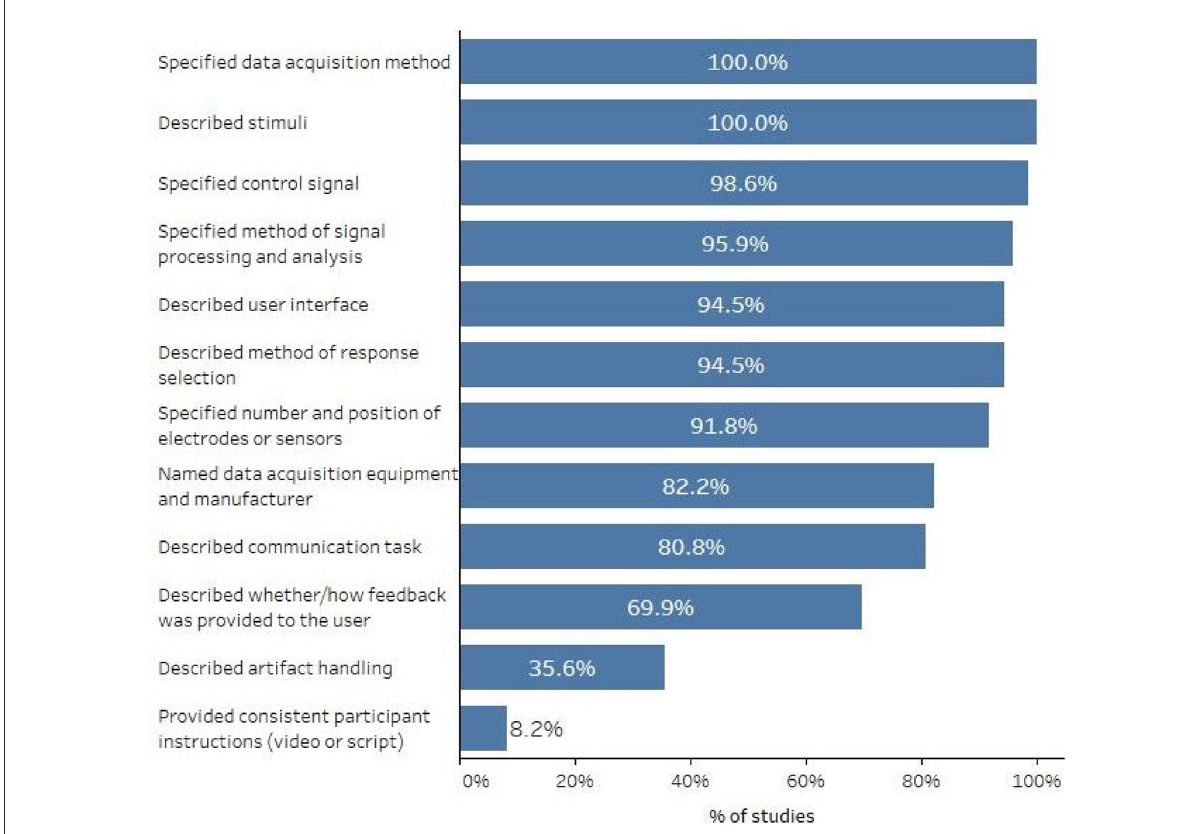
FIGURE4 Percent of studies that described various system and protocol